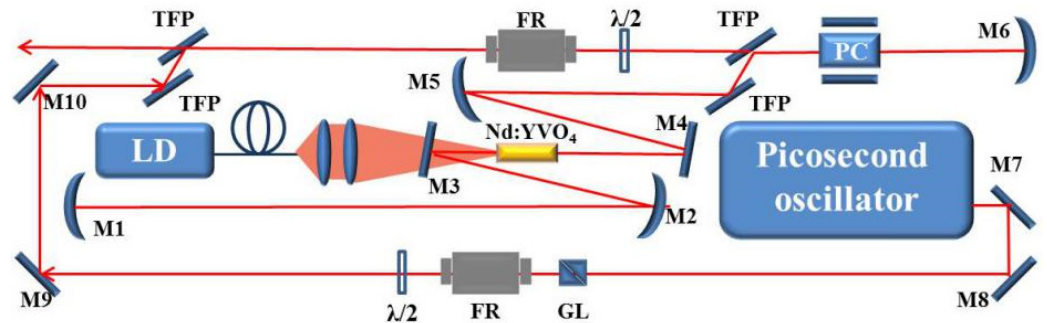
Figure 10. Diagram of the regenerative amplifier running at the repetition rate of 100 kHz. M1, M6: Concave mirrors, R = 900 mm; M2, M5: Concave mirrors, R = 600 mm; M3, M4,